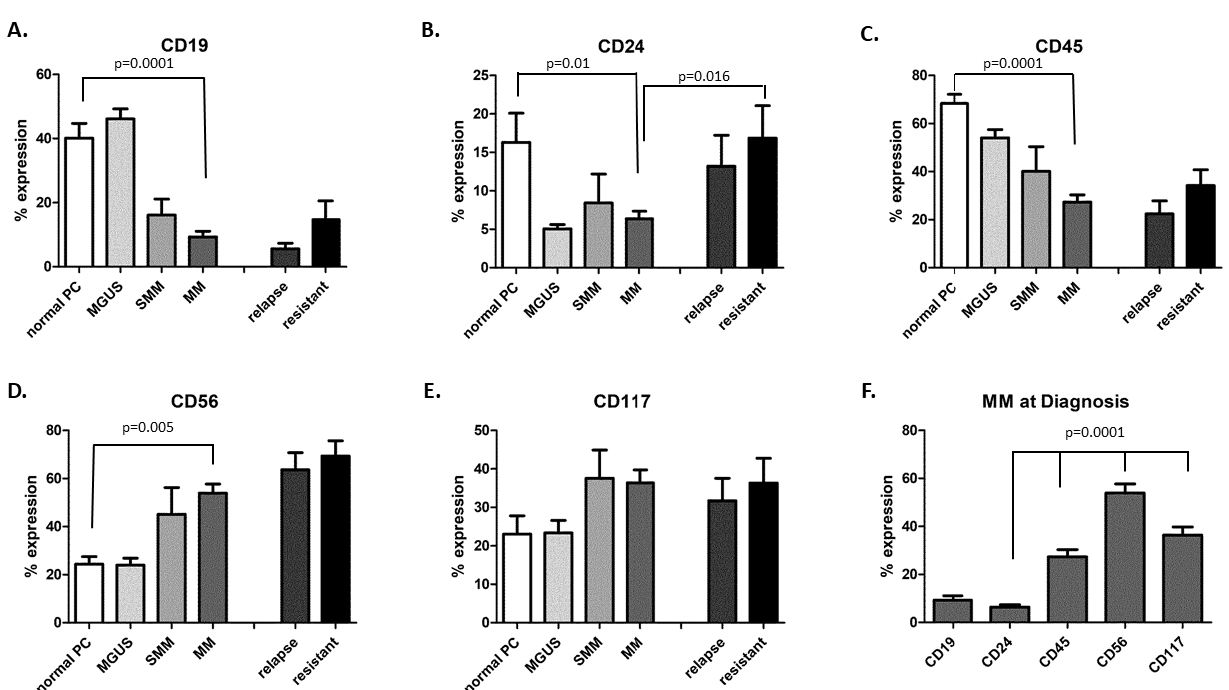
Figure 1. Flow cytometry level of CD expression on plasma cells at the different stages of MM development ( A – E ) and combined at diagnosis ( F ). Abbreviations—PC: plasma cells, MGUS: monoclonal gammopathy of undetermined significance, SMM: smoldering multiple myeloma, MM: multiple myeloma. Table 1. Patient baseline characteristics at diagnosis for the main